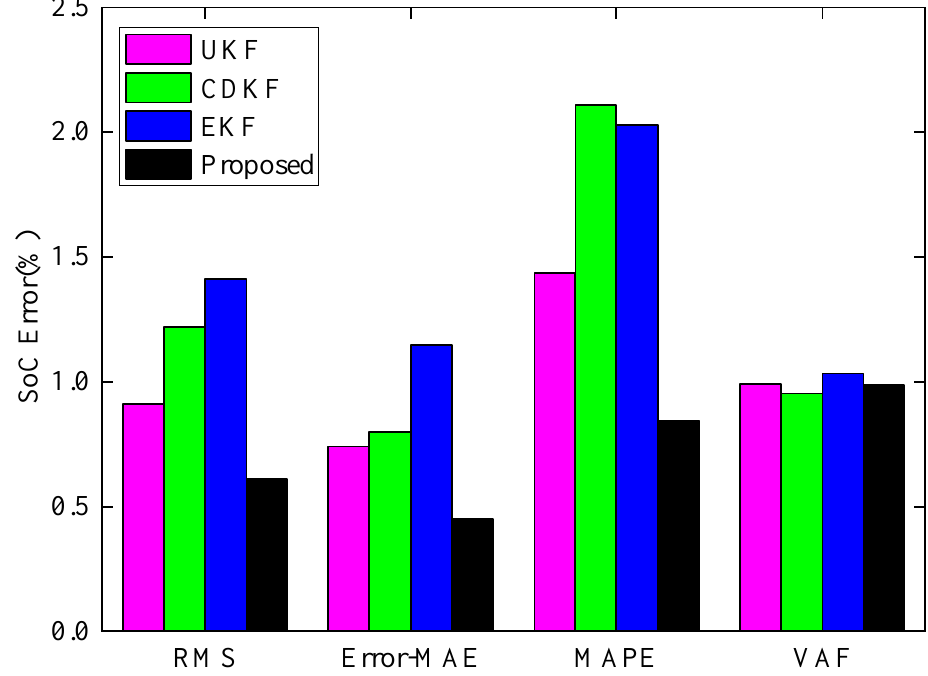
Figure 15. The four evaluation indexes of the initial SoC guess were 0.7 under the US06 condition.